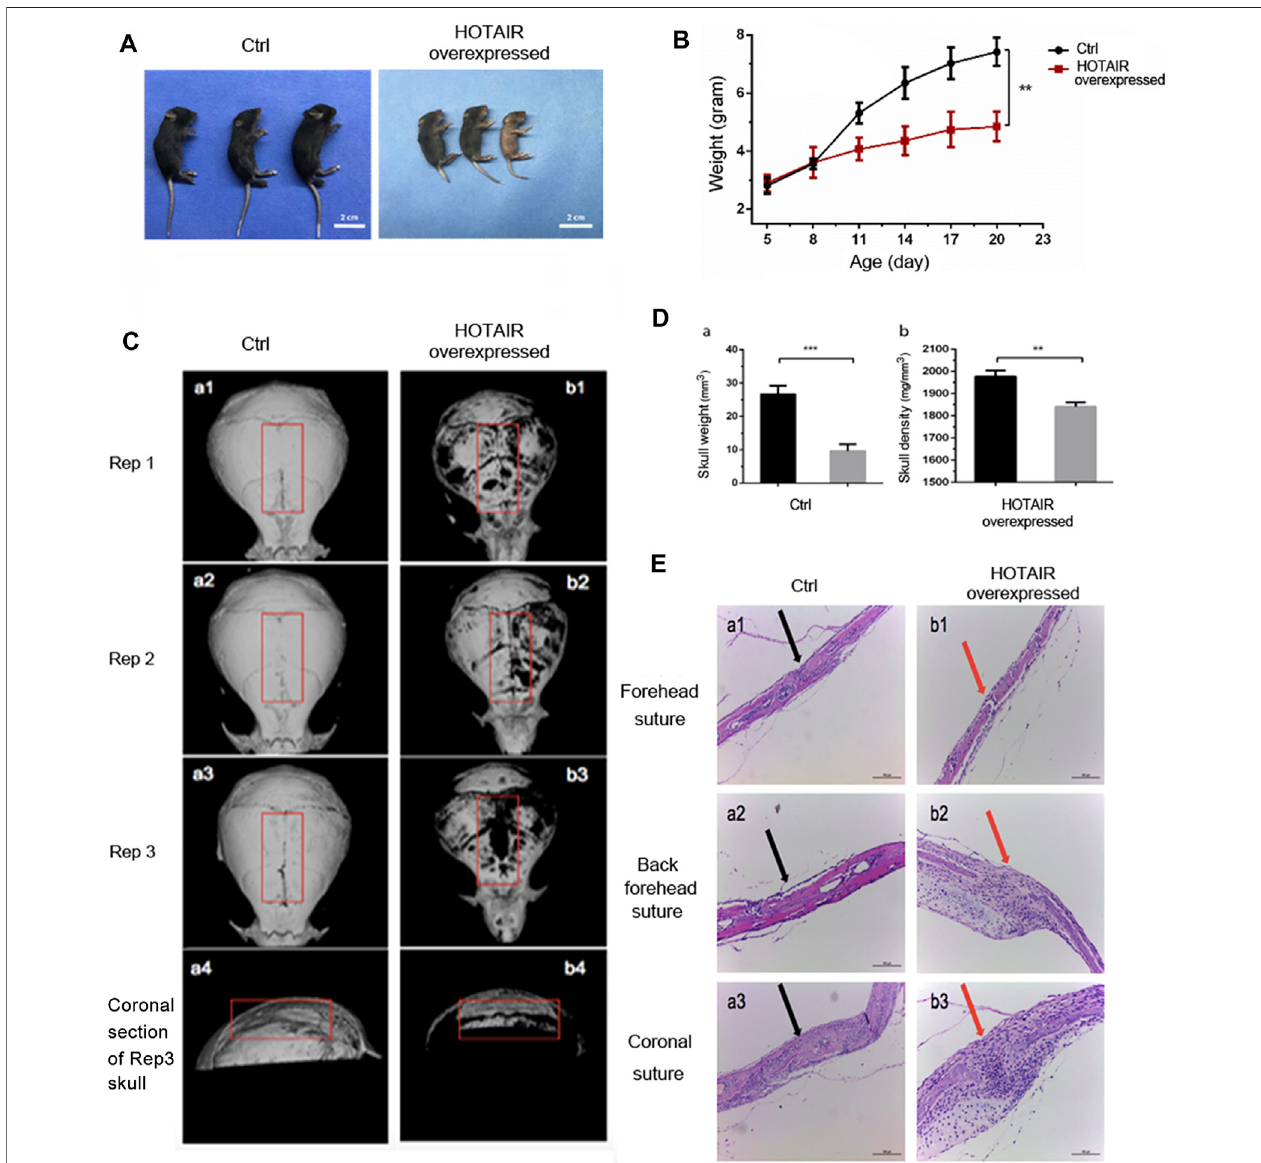
FIGURE 3 | The phenotype of HOTAIR in mouse model (A) The effect of HOTAIR on the physical development of C57 mice after 20 days ’ birth (B) Quantitative assayofthemiceweightedalongthedaysafterbirth (C) ImagesofCTscanofthemouseskull(a1-a3showtheCTscanimagesoftheisolatedskullsofthreereplicatesof 20-day-old WT mice, a4 shows the coronal section of a3 skull. b1-b3 shows the CT scan images of the isolated skulls of three replicates of 20-day-old HOTAIR overexpressed mice, b4 show the coronal section of the b3 skull) (D) Quantitative assay of the weight and bone density of mouse skull with CT scan (** p < 0.01, *** p < 0.001) (E) HE assays ofthe effect of overexpression of HOTAIR on the skull sutures in mice. Arrows point to the cranial sutures of mice. The scale of the images is 150